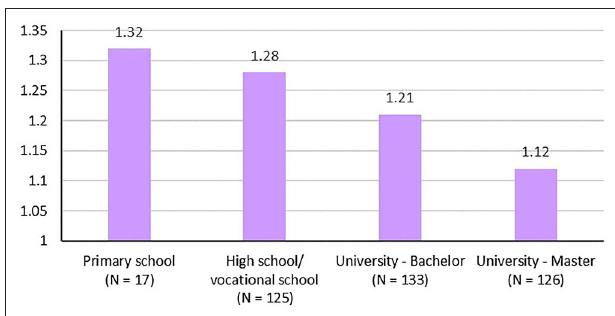
FIGURE 1 | Highest achieved education and trust in